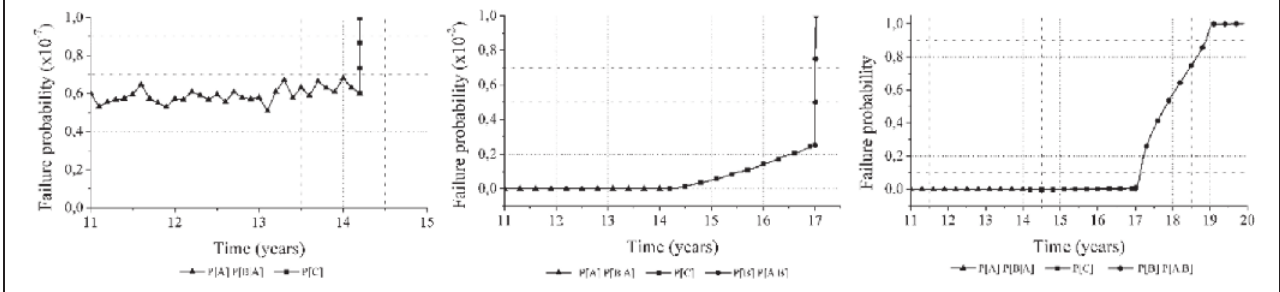
Figure 9 – Evolution of the probability of failure considering only the most probable failure path.